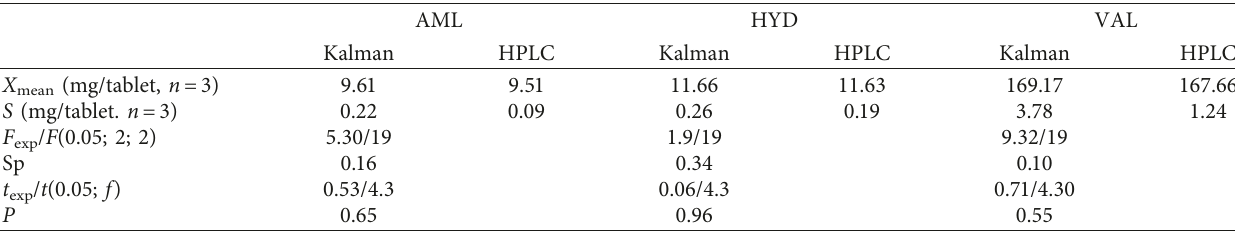
Table 9: Comparison of AML, HYD, and VAL contents in Exforge HCTtablet measured ( n � 3) by using the developed method and HPLC